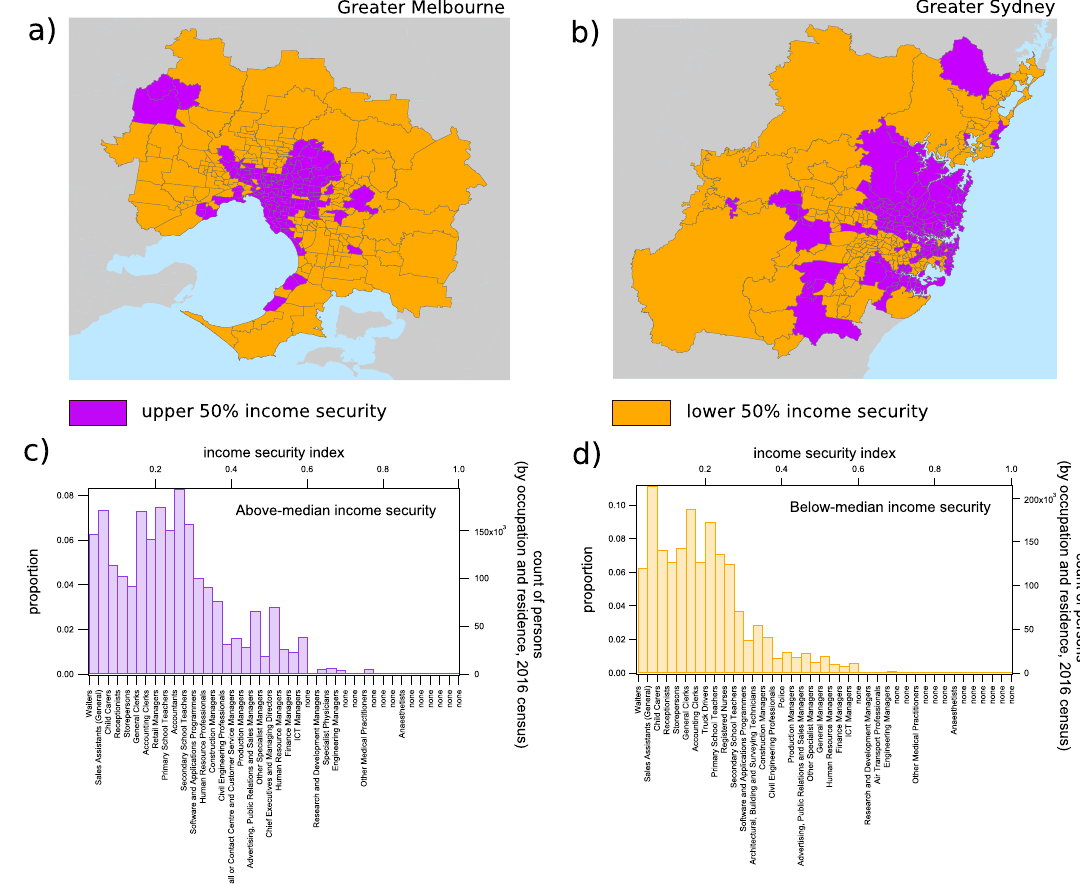
Figure 2. Geospatial and occupational distribution of income security. The choropleth maps in ( a ) and ( b ) demonstrate the geospatial distribution of income security in Greater Melbourne and Greater Sydney (respectively) on the scale of Statistical Area Level 2 (SA2). Areas below the median income security index of 0.1809 are colored orange while those above the median are colored purple. The histograms in ( c ) and ( d ) demonstrate the distribution of the population in these regions over the income security spectrum, with indicative occupation types for each bin shown in the bottom y-axis labels (the label corresponding to the most prevalent occupation classification for each bin is shown). For both histograms, waiters have the lowest income security, while anaesthetists have the